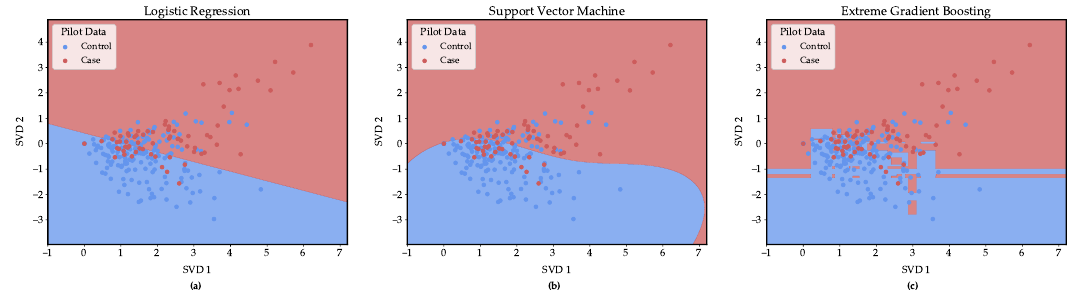
Figure 3. Decision boundaries for ( a ) logistic regression (LR), ( b ) support vector machine (SVM), and ( c ) extreme gradient boosting (XGB) models. Controls without mental illness and suicidal language samples from ACT and STM studies were dimensionally reduced using singular value decomposition. ML models were trained on dimensionally reduced language samples and used to classify coordinate points to create decision boundaries. The red and blue regions indicate coordinates that correspond to case and control classification, respectively. The red and blue points show dimensionally reduced language samples collected in this pilot. The LR model ( a ) shows the simplest rules used for classification and the XGB model ( c ) creates the most complex rules. Model performance indicated in these figures does not represent performance on non-dimensionally reduced